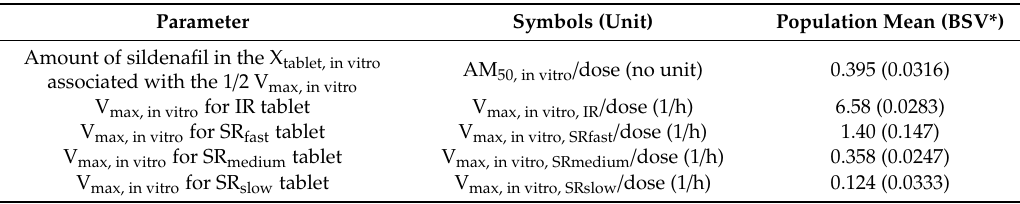
Table 3. In vitro dissolution parameter estimates.